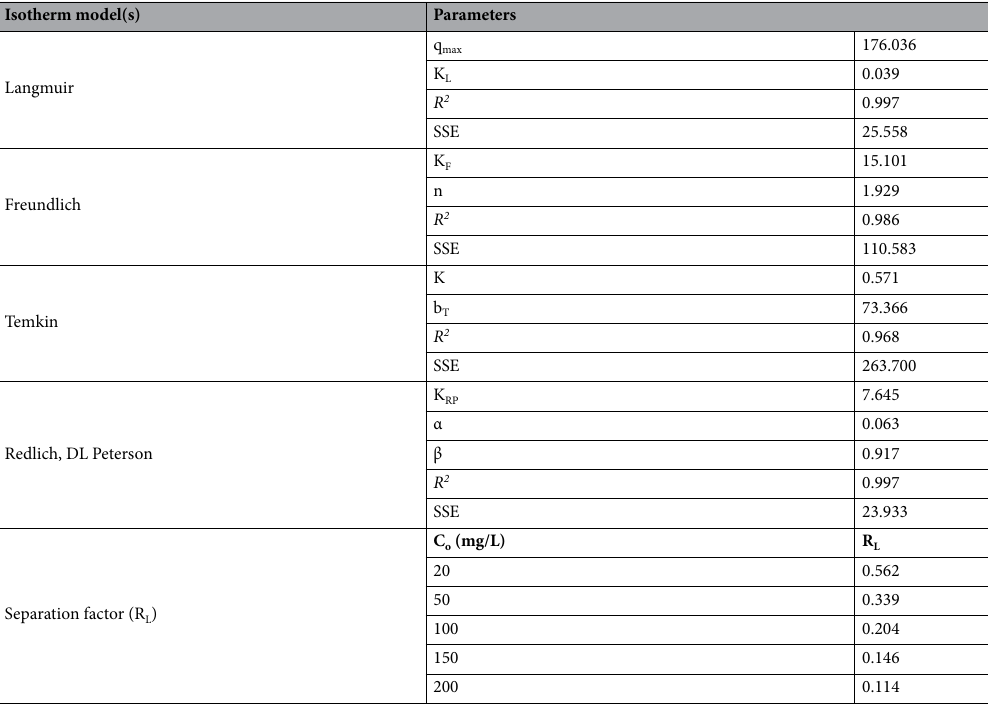
Table 2. The parameters of isotherm models and equilibrium parameters for PNP adsorption on TMA-(PA6- g